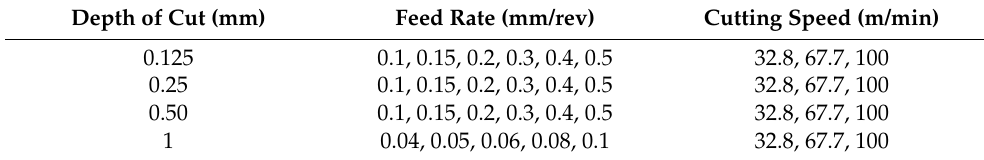
Table 2. Combination of cutting parameters for the cutting tests carried out under LIL